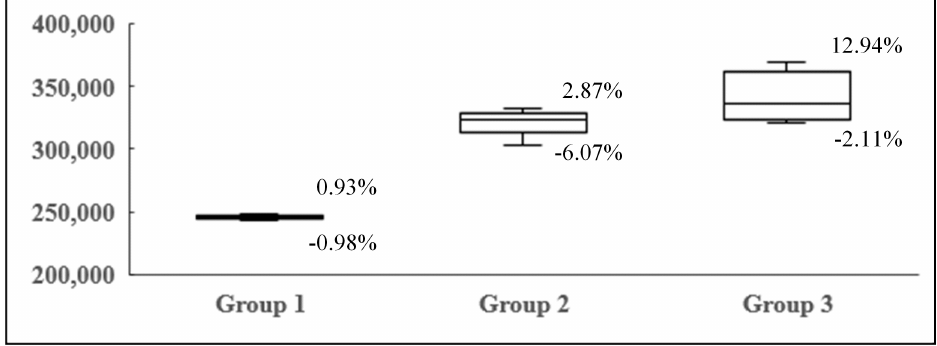
Fig 10. The box-plot of revenue in each